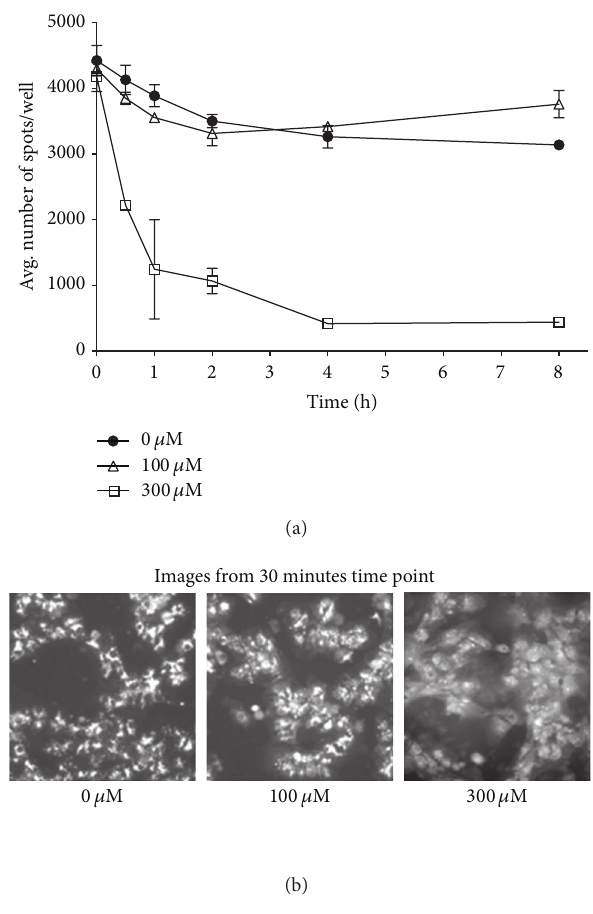
Figure 7: NMTMB affected acridine orange (AO) staining of lyso- somes of rat hepatocytes over an 8-hour time course. AO was added to hepatocyte media for 10 minutes, removed, and replaced with media containing compound. Treatment with NMTMB proceeded for 30 minutes, 1h, 2h, 4h or 8h. AO staining was monitored using the Cellomics Arrayscan instrument. The data are expressed as an average of 3 replicates ( ± SD) from a single cell isolate. A statistically significant difference between control replicates and that for the NMTMB high test concentration is achieved by 30 min ( 𝑃 < 0.05 , 𝑡 -test) where marked cytotoxicity is evident by 4hr (see Figure 5). Images from the Cellomics at the 30-minute time point are presented in